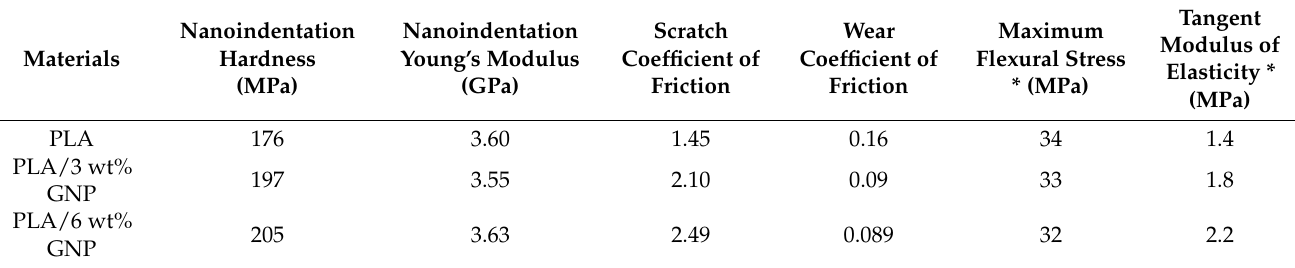
Table 2. Mechanical properties of the investigated